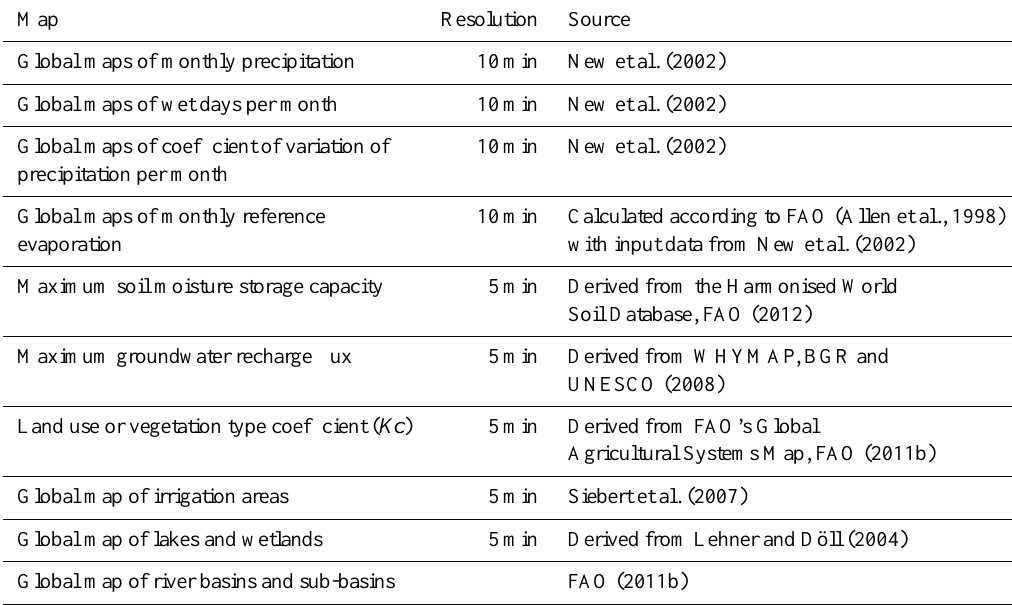
Table 3. Input data